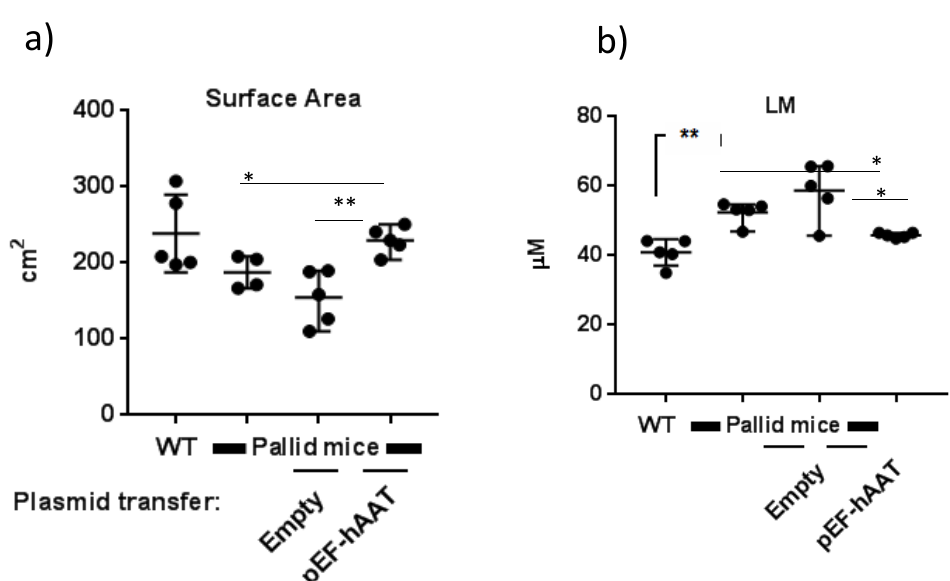
10 of 14 Table 2. Parameters for stereology (Figure 4): data are presented as mean ± SEM.